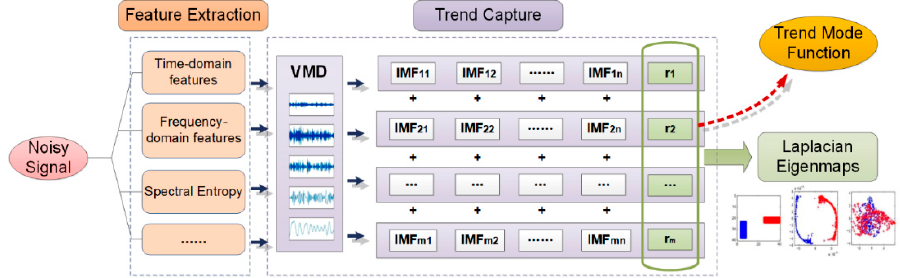
Figure 4. Proposed method for the degradation feature extraction.